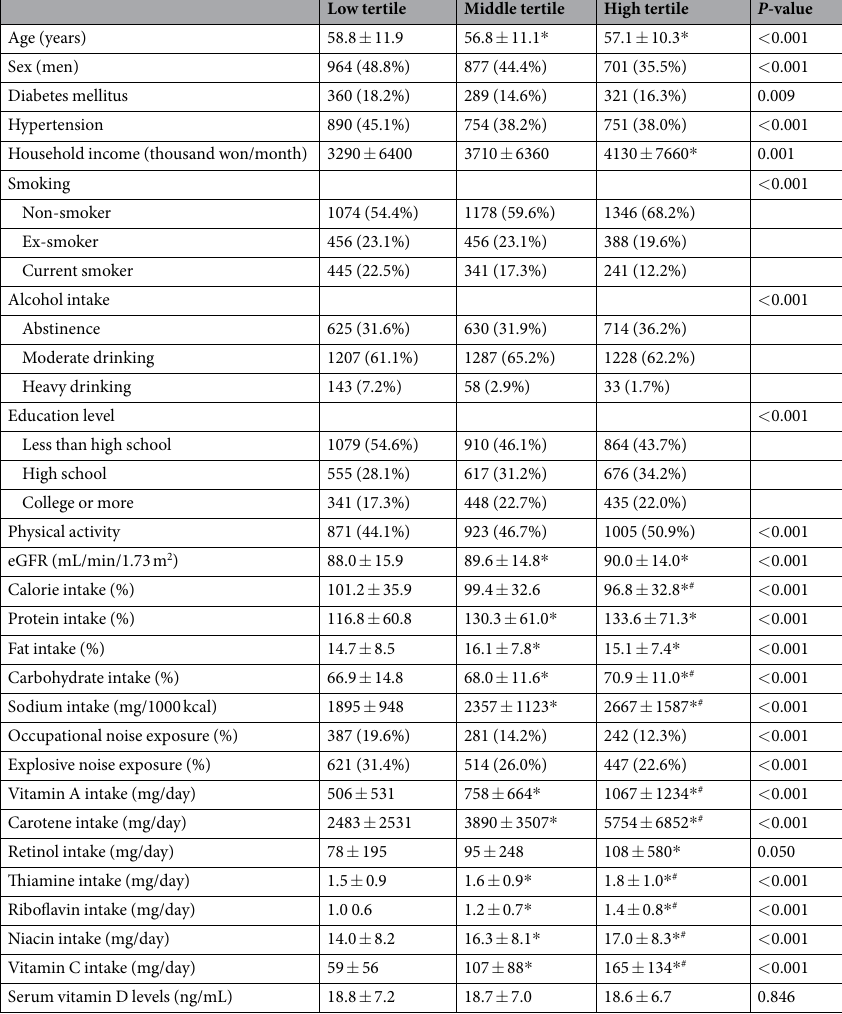
Table 2. Clinical characteristics of participants according to the potassium intake tertile’. The data are expressed as numbers (percentages) for categorical variables and means ± standard deviations for continuous variables. The differences between the potassium intake tertiles were tested using one-way analysis of variance for continuous variables, followed by post hoc Tukey comparisons, and Pearson’s χ 2 test or Fisher’s exact test for categorical variables. * P < 0.05 versus the low tertile group. # P < 0.05 versus the middle tertile group. Abbreviations: eGFR, estimated glomerular filtration